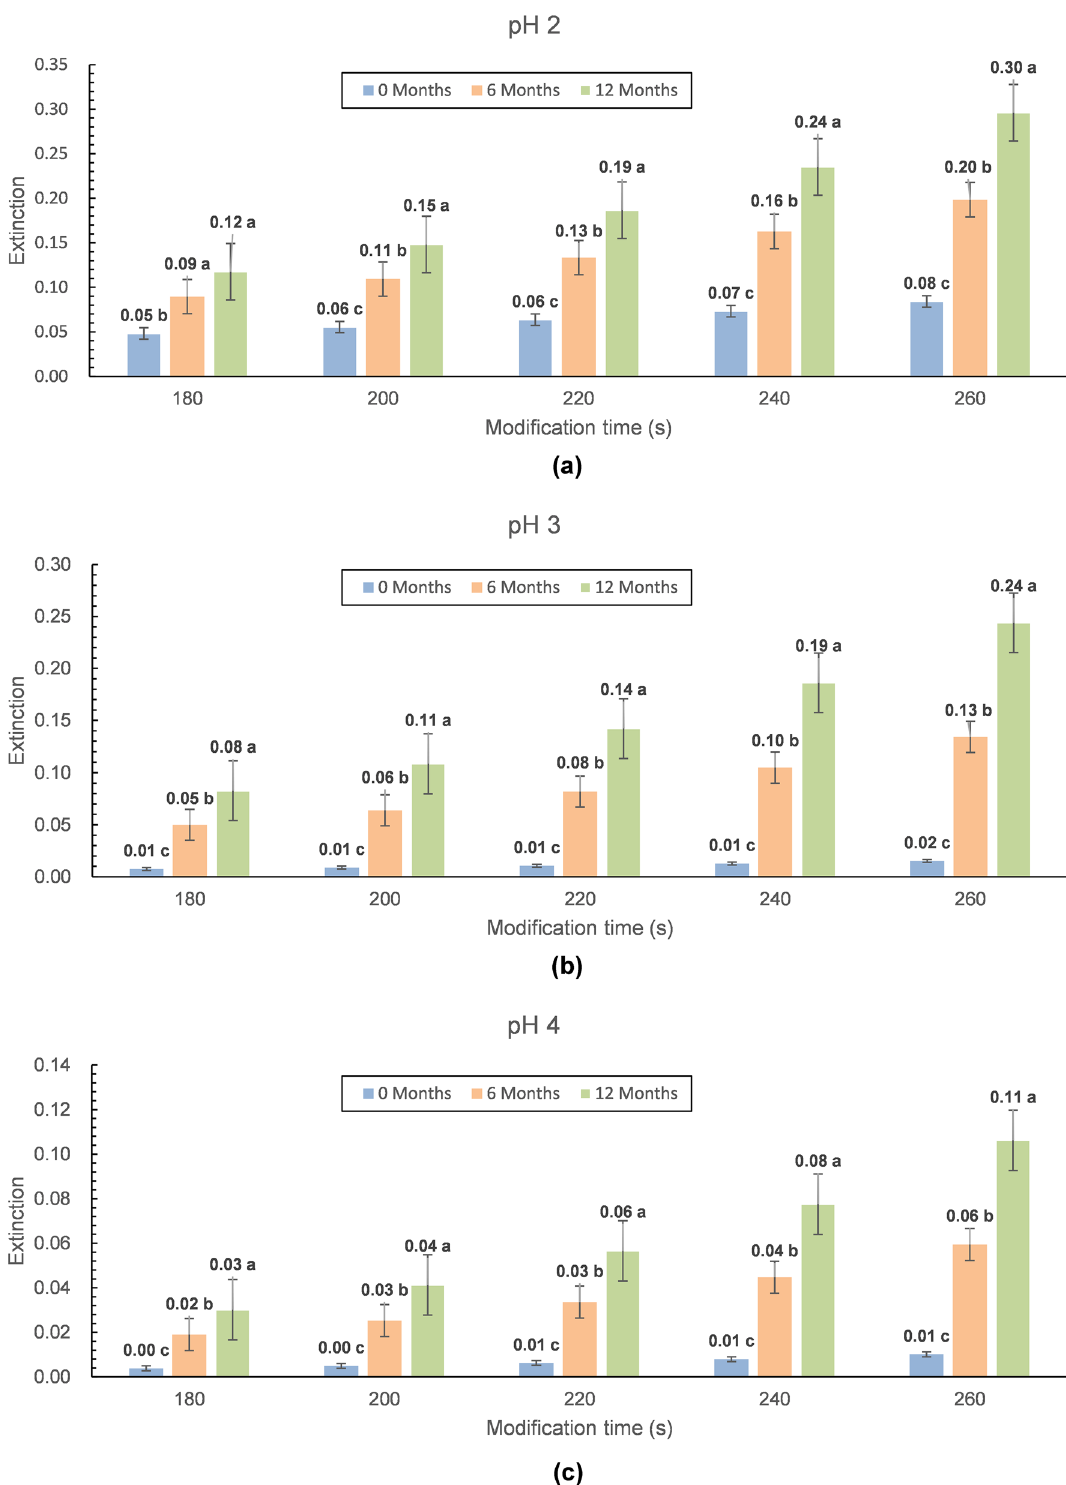
Figure 5. Graphical interpretation of the storage changes in the colour of microwave-modified lysozyme preparations ( a —pH 2, b —pH 3, c —pH 4). Storage times: 0, 6, and 12 months. Time of modification: 180, 200, 220, 240, and 260 s. ( a–c Different letters on the bars denote a significant difference in the means at p ≤ 0.05— separately considered for each modification